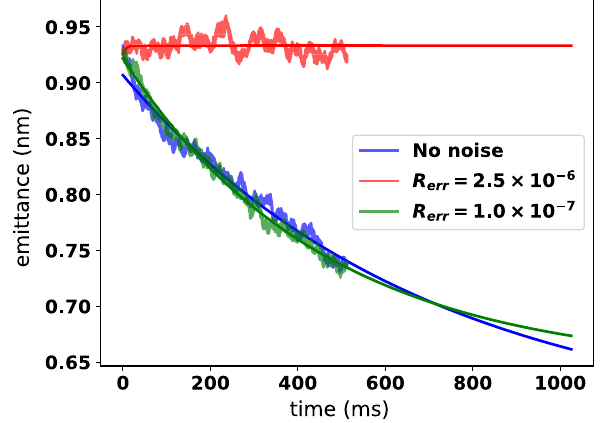
FIG. 8. Particle tracking results for OSC BMAD simulations that include both OSC and SR damping, QF and OSC incoherent kicks. Various levels of dipole noise are included. The solid lines are exponential best